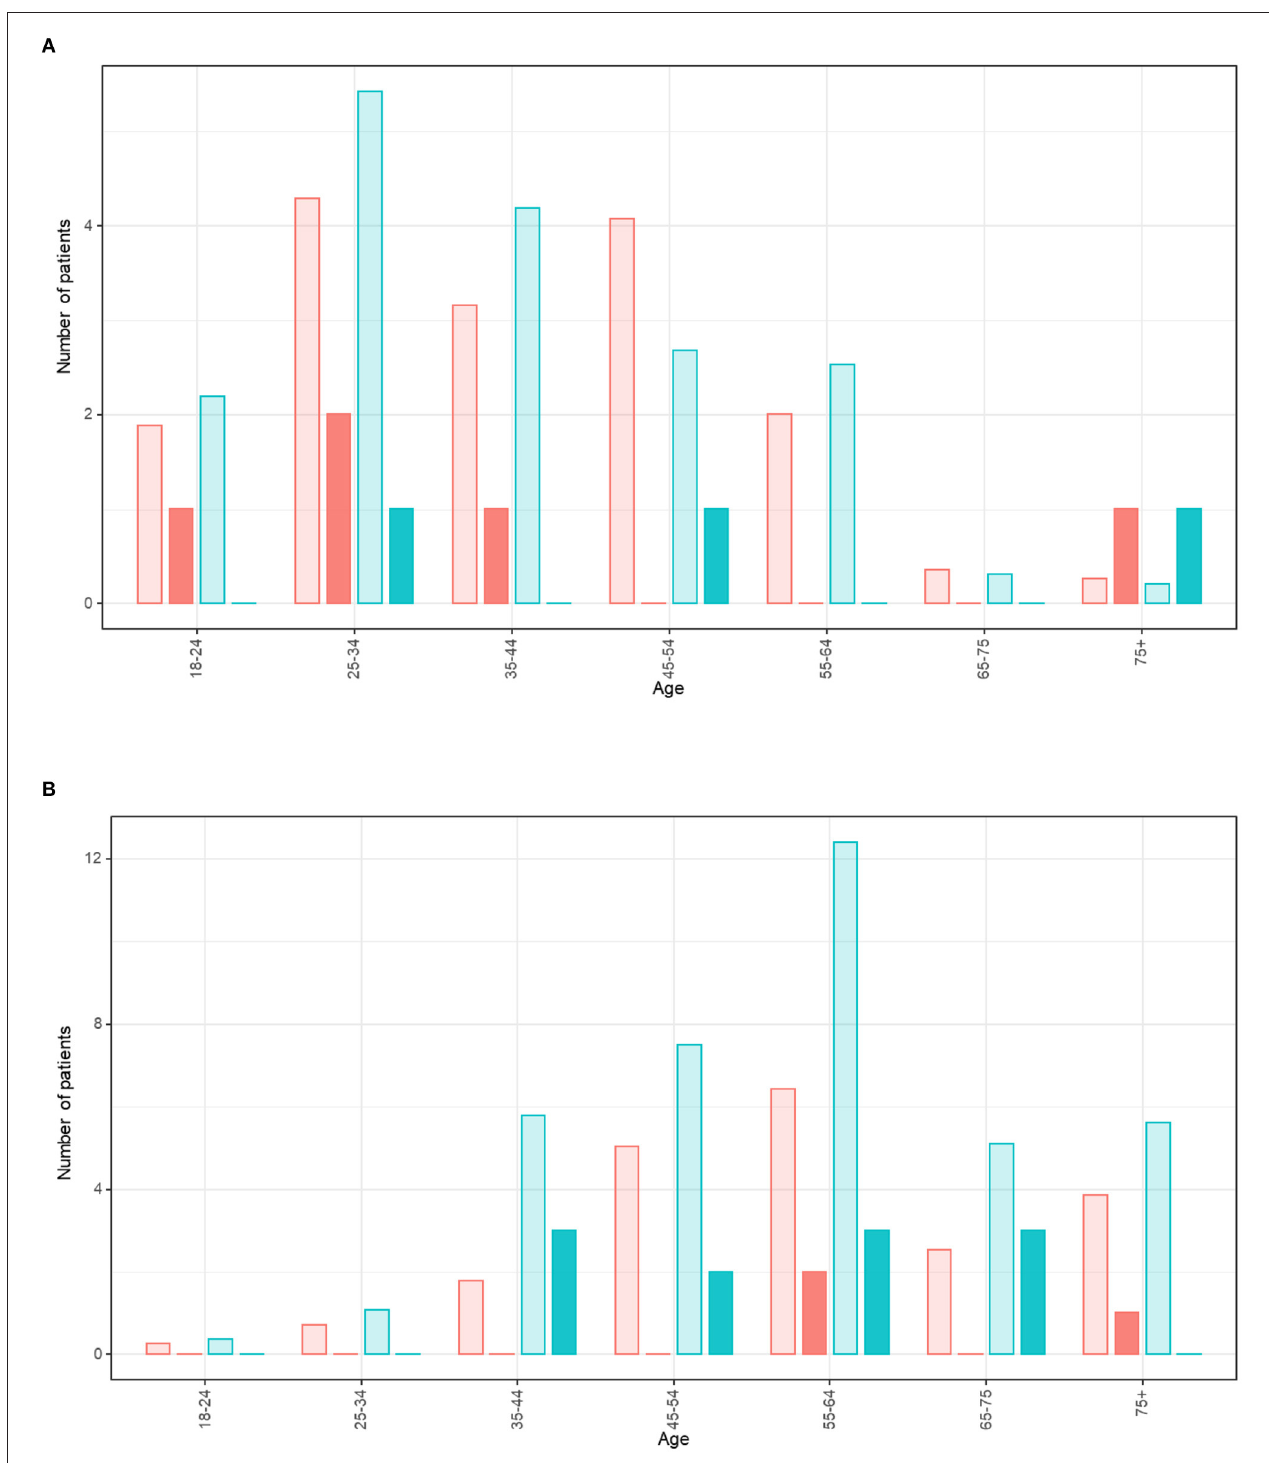
FIGURE 2 | Expected and observed number of cases of daily smokers amongst patients with COVID-19 (categorised by age and gender). (A) For outpatients. (B) For inpatients. The red bars represent female smokers and blue bars represent male smokers. The bars with lighter shading represent the expected number of daily smokers of each age and gender amongst the patients with COVID-19 in reference to 2019 French general population. The dark bars represent the observed number of daily smokers of each age and gender amongst the patients with COVID-19.